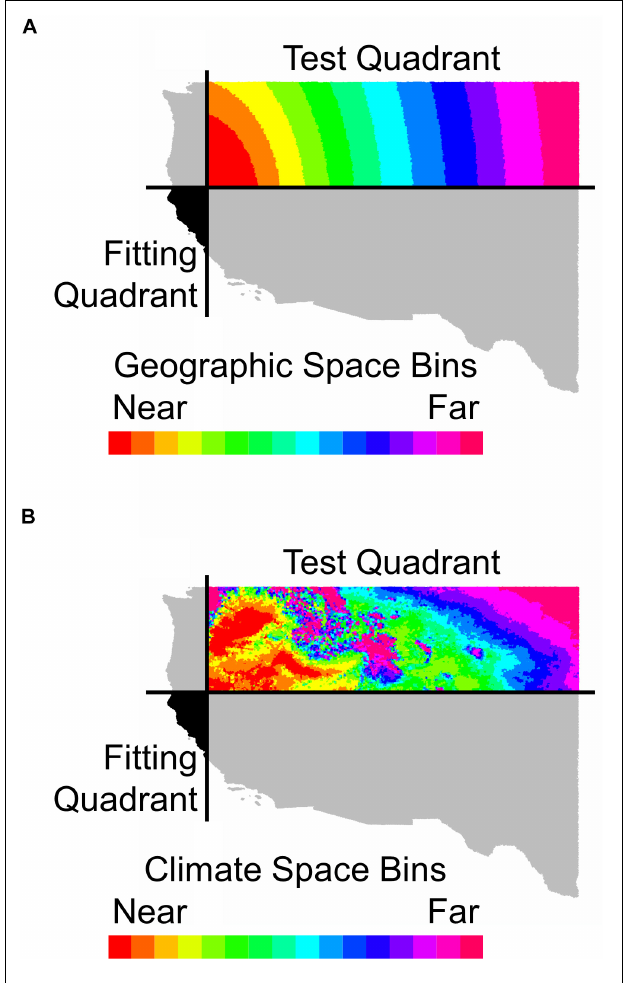
FIGURE 1 | An illustration of how holdout sites were binned by distance (A) in geographic space or (B) in environmental space from the fitting region for Calocedrus decurrens. This map depicts the geographic extent of all FIA data used in the study. The horizontal and vertical black lines in (A,B) represent median latitude and longitude, respectively. The black area shows the quadrant used for model fitting and gray shaded quadrants were neither used for model fitting or testing. The colored areas indicate bins in either geographic or environmental space used for model testing with near and far referring to distance in geographic or climatic